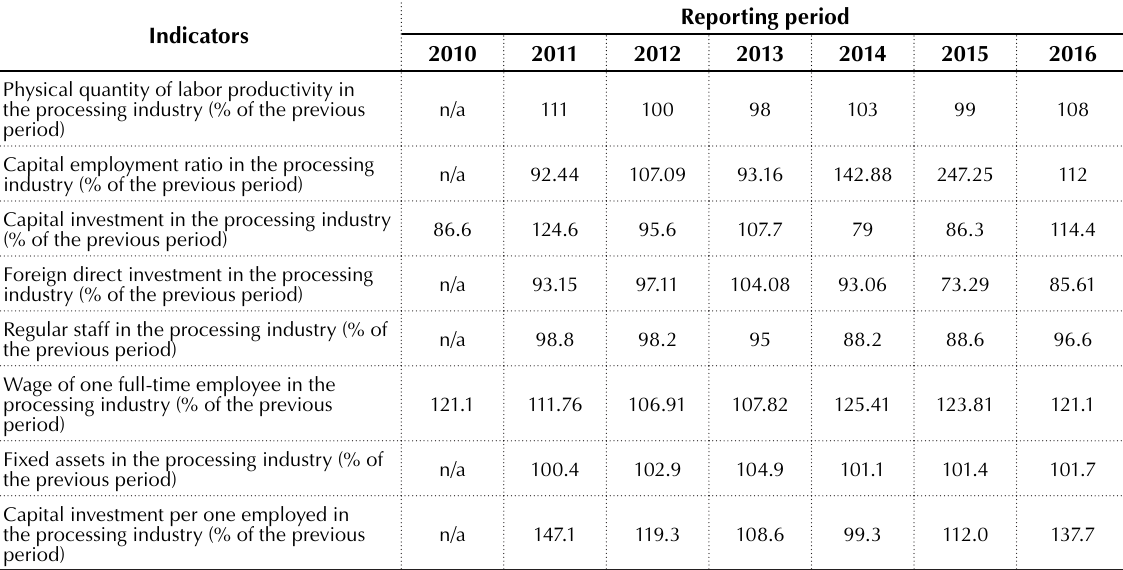
Source: Calculated based on State Statistics Service of Ukraine